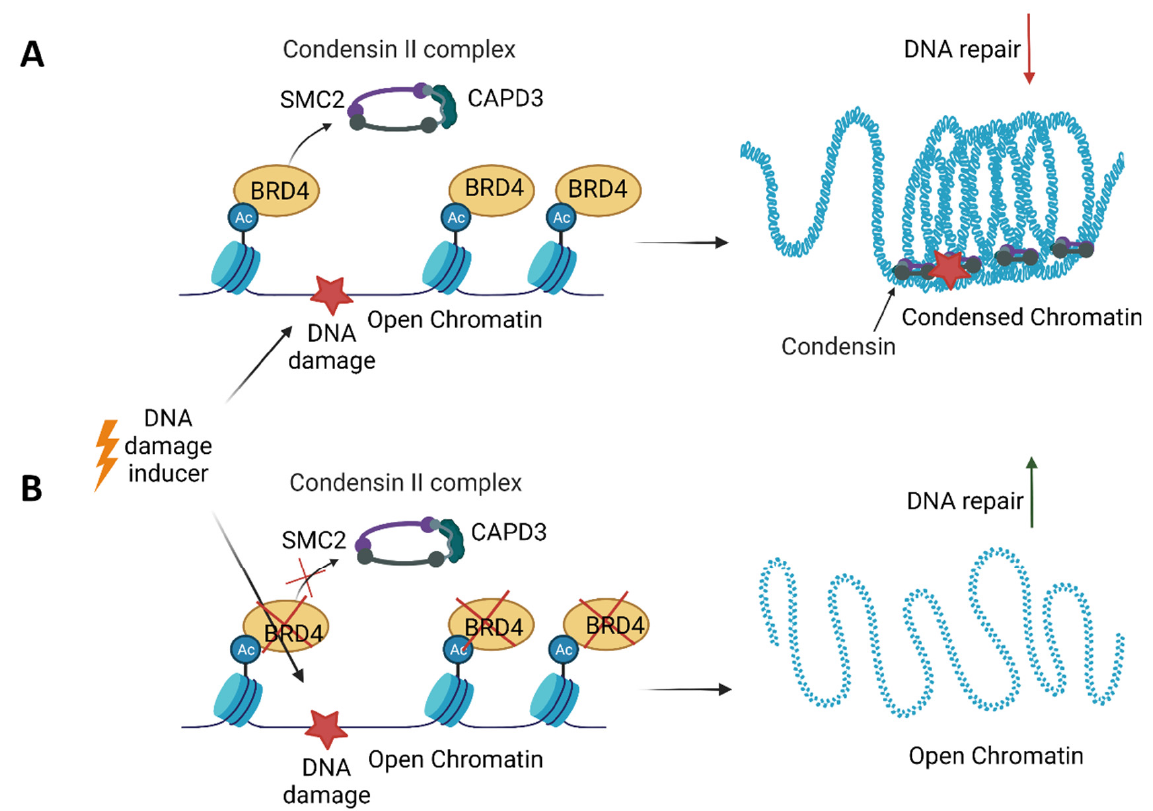
Figure 5. An isoform B of bromodomain and the extraterminal domain 4 (BRD4) protein participates in the persistence of DNA damage. ( A ) BRD4 binds acetylated histones in the open chromatin regions. Upon DNA damage, BRD4 recruits the condensin II complex consisting of SMC2 and CAPD3 to acetylated chromatin, resulting in chromatin compaction, the attenuation of DNA repair and the persistence of DNA damage. ( B ) In the absence of BRD4, the chromatin remains open, allowing for DNA repair upon DNA damage.